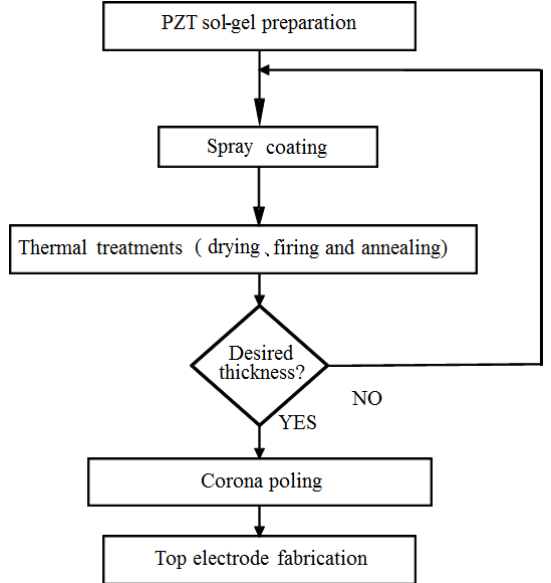
Figure 2. Flow chart of lead zirconate titanate (PZT) film fabrication procedures by the sol-gel spray coating technique, including sol-gel preparation, spray coating, thermal treatment, corona poling and fabrication of the top electrode.